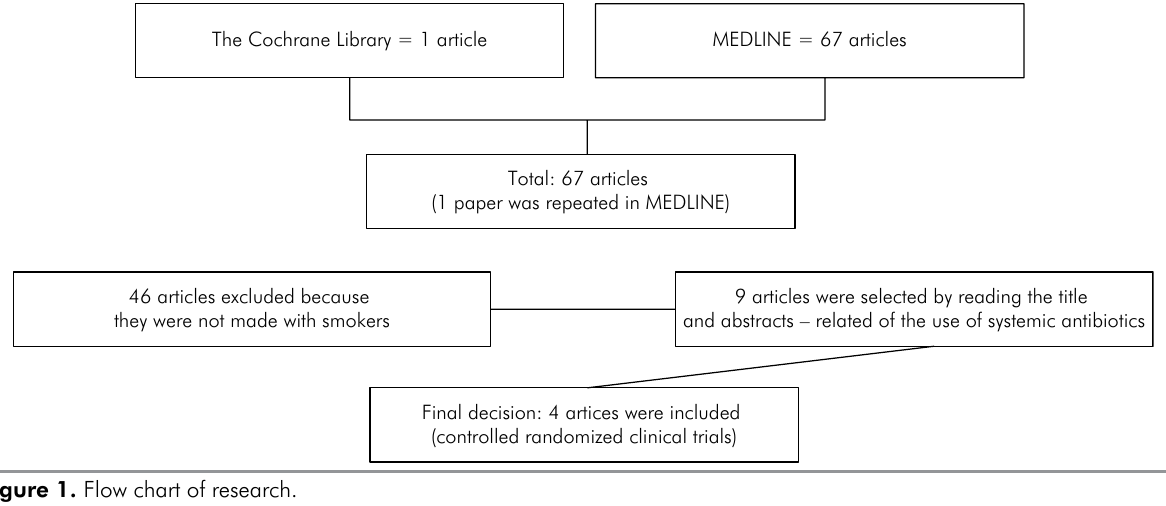
Figure 1. Flow chart of